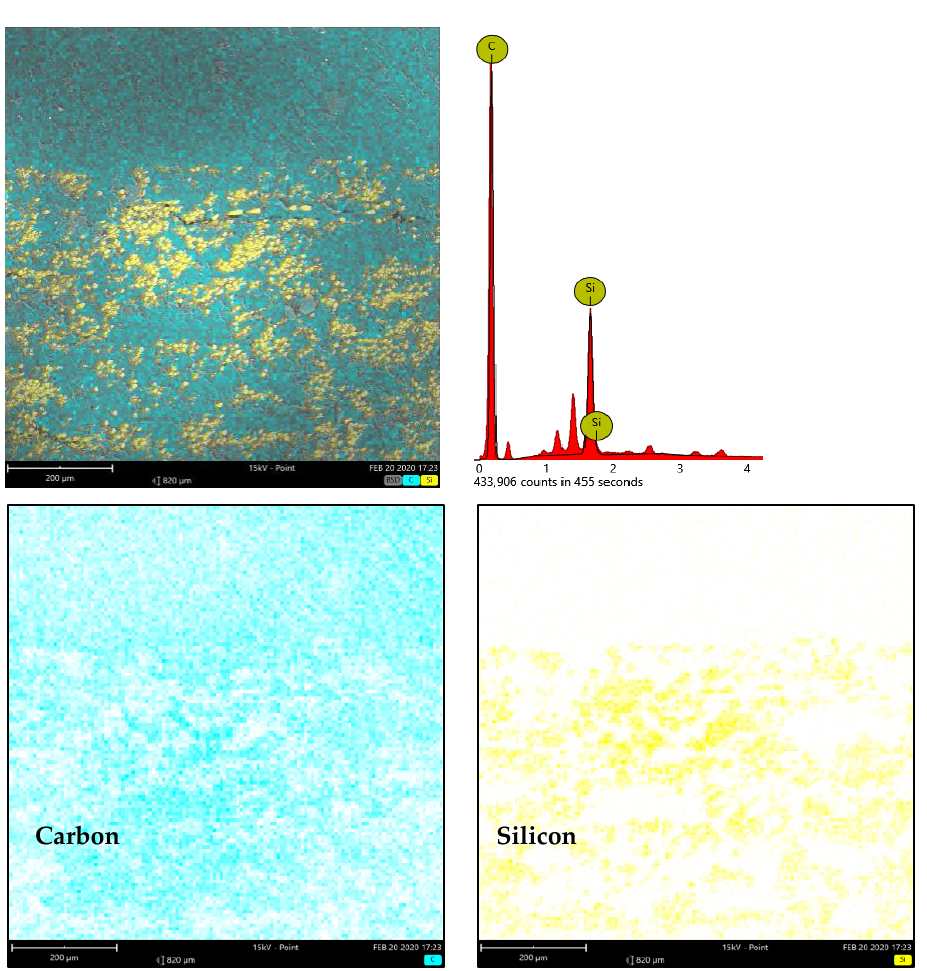
Figure 7. Energy dispersive X-ray (EDX) mapping analysis of 3D printed specimens showing layers with and without the presence of glass fibers.